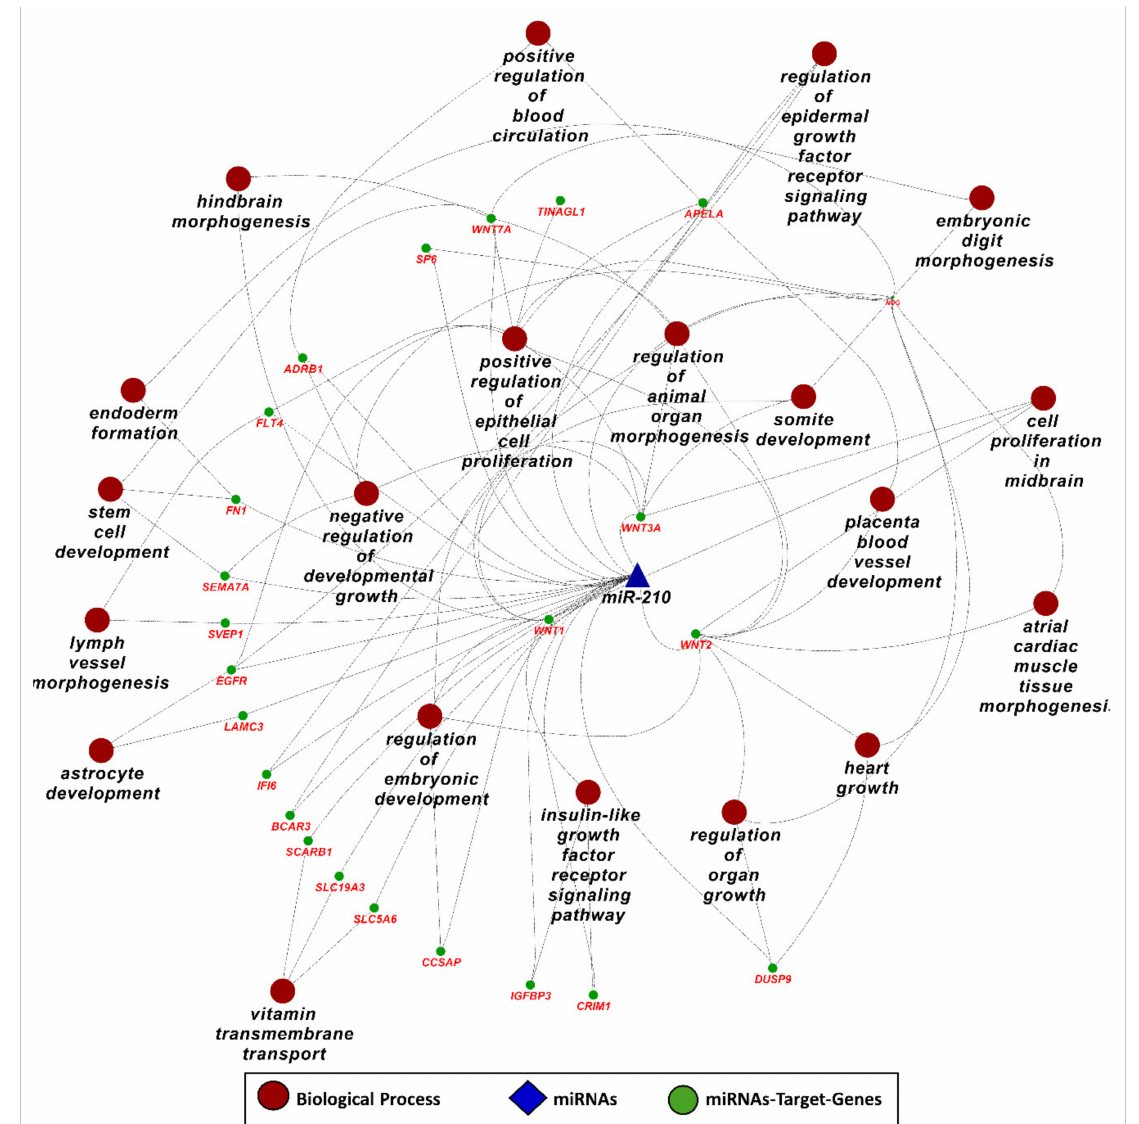
Figure 8. Gene ontology enrichment analysis for biological processes of miR-210 target genes from genes List 2, derived using ClueGO (version 2.5.1) and Cluepedia (version 1.5.7) plugin in Cytoscape (version 3.8.2) environment. A complete list of biological processes regulated by miR-210 is provided in Table